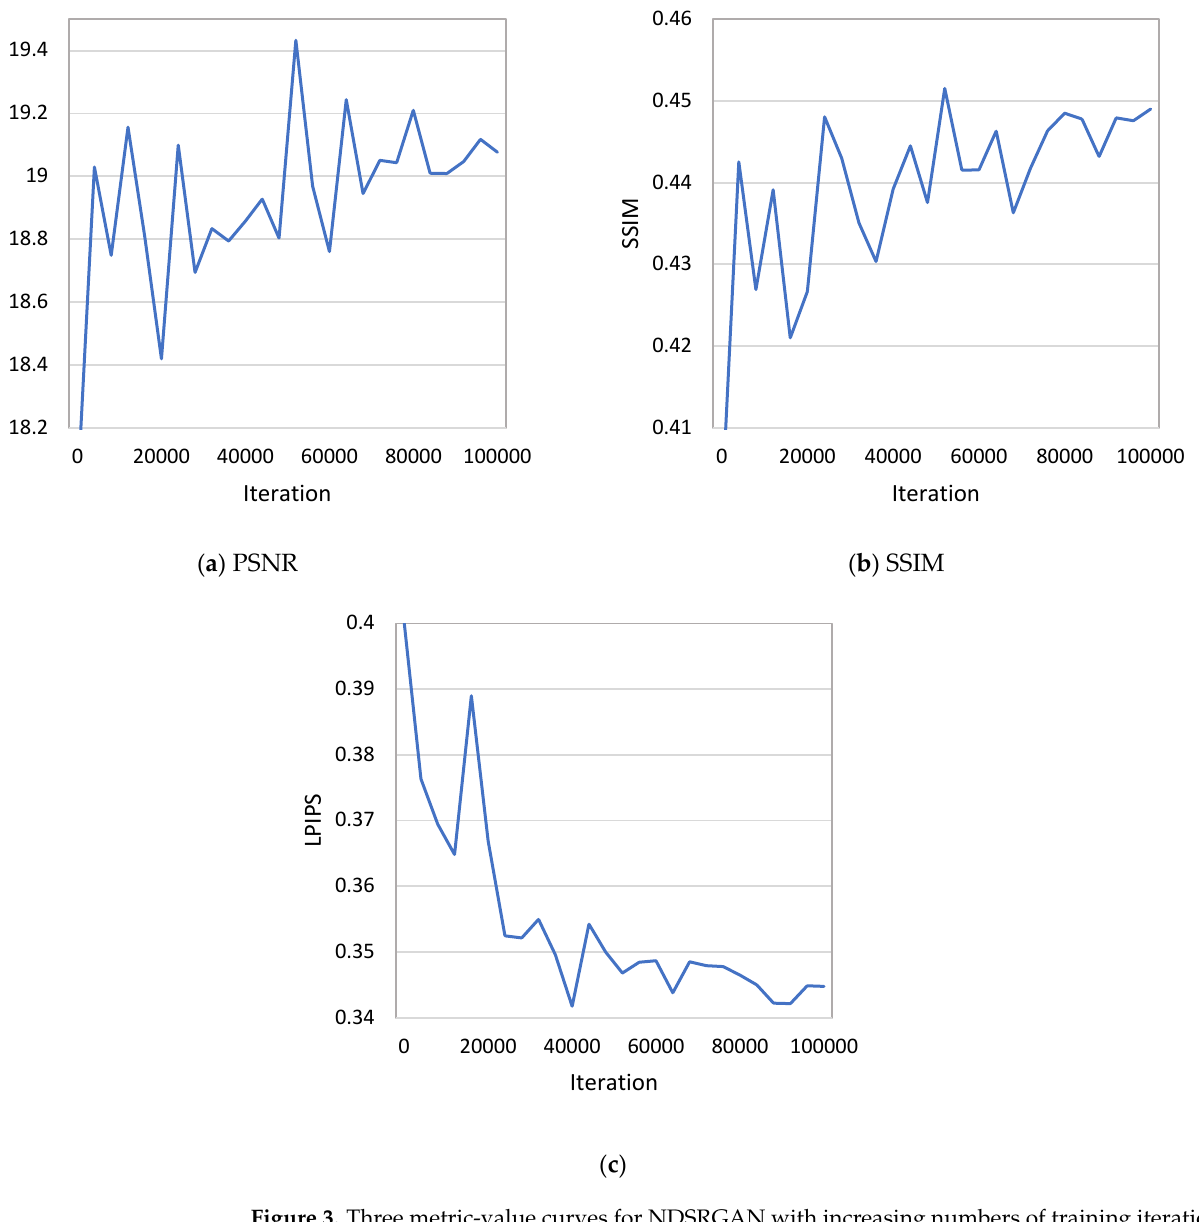
Figure 3. Three metric-value curves for NDSRGAN with increasing numbers of training iterations. ( a ) PSNR; ( b ) SSIM; ( c ) LPIPS.